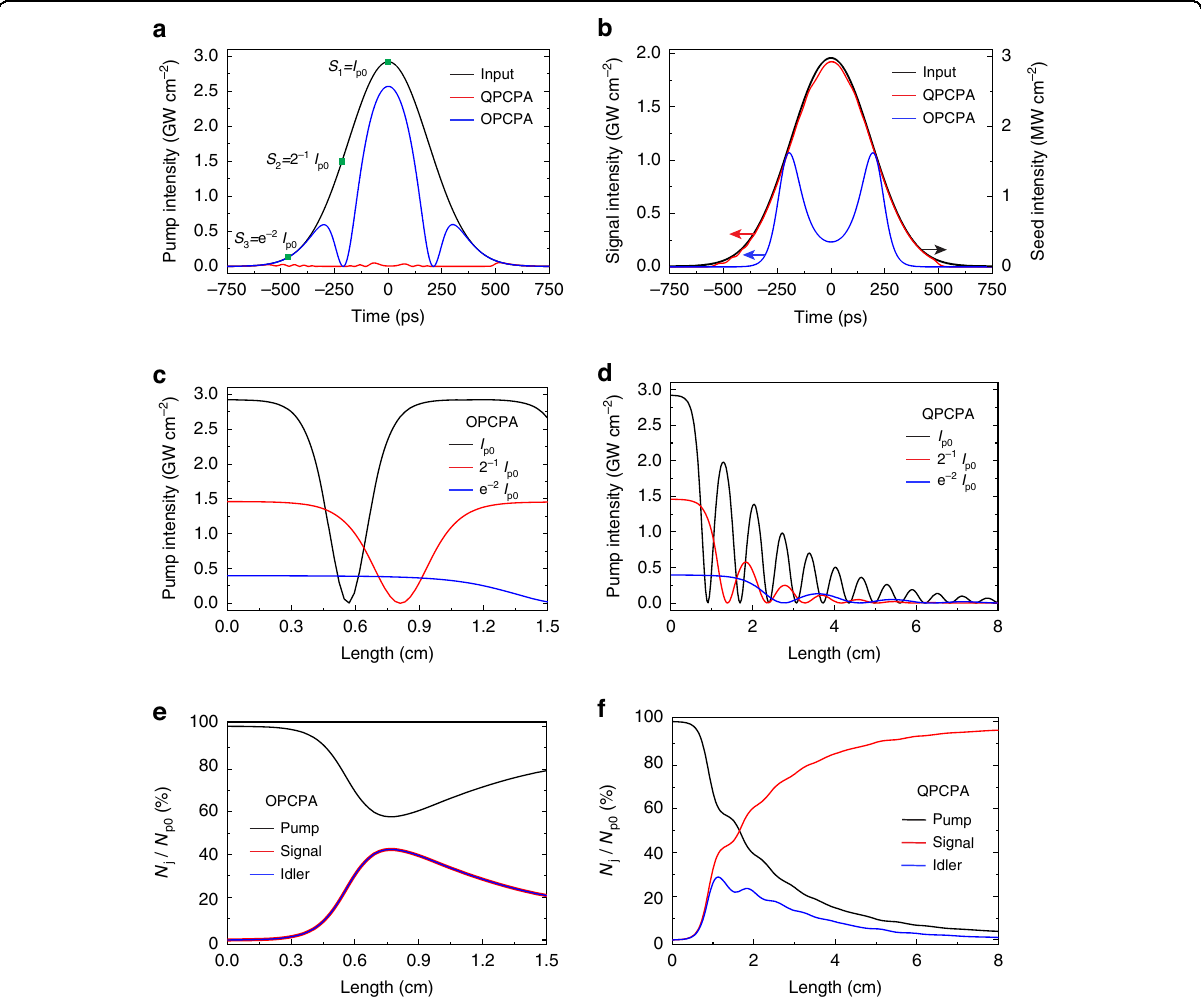
Fig. 1 Numerical comparisons of QPCPA and OPCPA. a Pump pulses at L = 8 cm for QPCPA (red) and L = 0.75 cm for OPCPA (blue). The input pump has a peak intensity of I p0 = 3 GW cm − 2 (black). b Signal pulses at L = 8 cm for QPCPA (red) and L = 0.75 cm for OPCPA (blue). The input signal has a peak intensity of 3 MW cm − 2 (black). c Evolution of the three OPCPA pump intensities marked in a . d Evolution of the three QPCPA pump intensities marked in a . e Evolutions of OPCPA photon numbers N j relative to the input pump photon number N p0 , where j = p , s , and i represent pump, signal, and idler, respectively. f Evolution of the QPCPA photon number. See Methods for simulation parameter